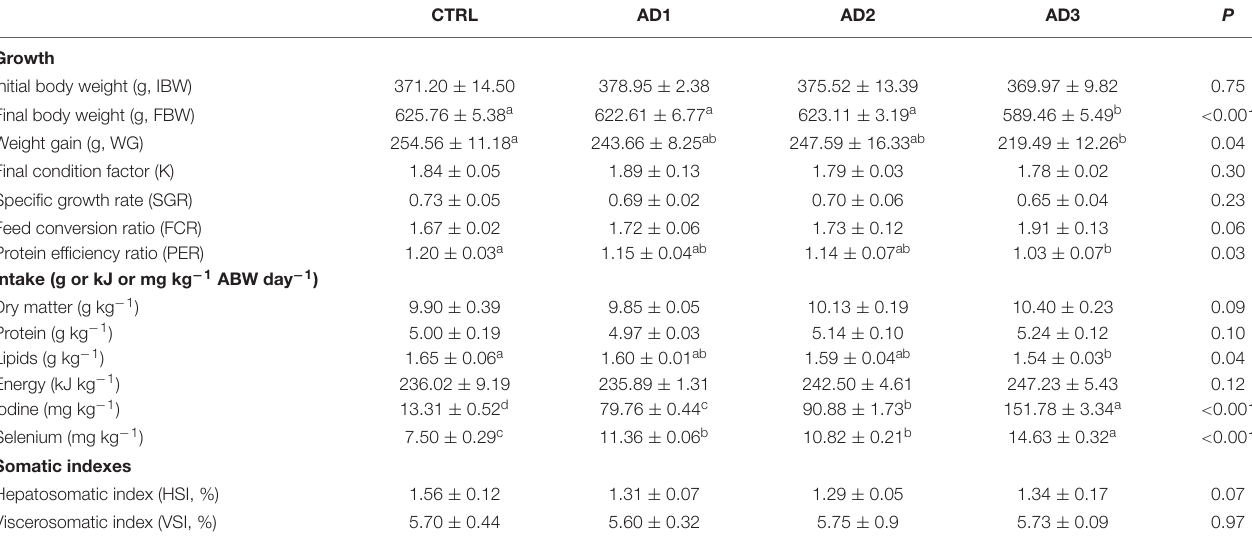
TABLE 4 | Growth performance and somatic indexes of gilthead seabream fed the experimental diets for 85 days. CTRL AD1 AD2 AD3 P